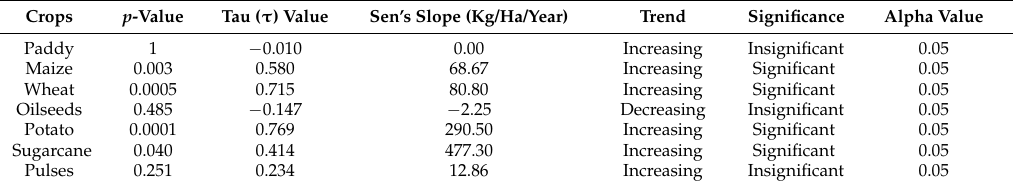
Table 11. Mann–Kendall test and Sen’s slope results for yields of major crops (1999 to 2014). Crops